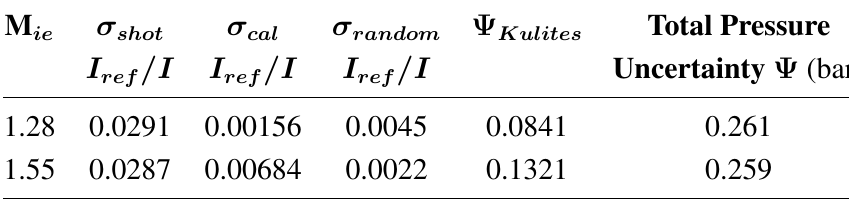
Table 2. PSP uncertainty.